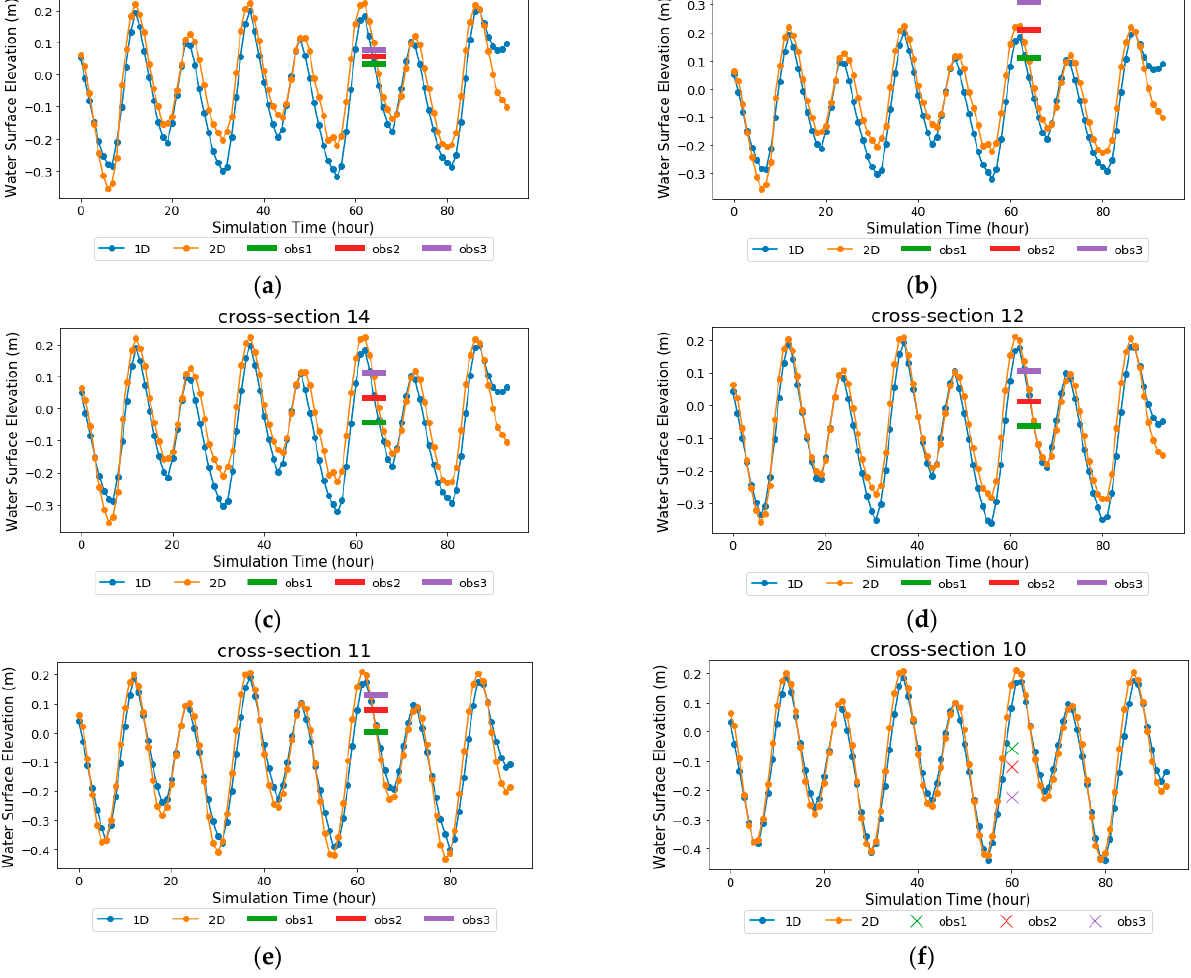
Figure 3. Observed Water Surface Elevations on 27 September 2010 and the corresponding HEC-RAS 1D and 2D model simulations (from 25 to 28 September). Orange represents HEC-RAS 2D results, blue represents HEC-RAS 1D results; obs1, 2, and 3 represent observations along the cross-section during different times. The horizontal line represents the duration of taking the measurements from 3 to 7 pm. Results are shown for different cross-sections ( a – f representing crosssections 17, 16, 14, 12–10, respectively) along the river (Figures 1 and S1). The exact time of the measurements is available for Section#10 (at 1 pm).